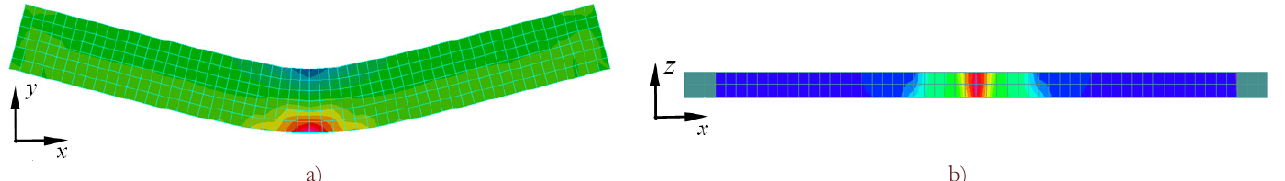
of concrete FEs reported xx  c of FRP FEs in the fibre 1 